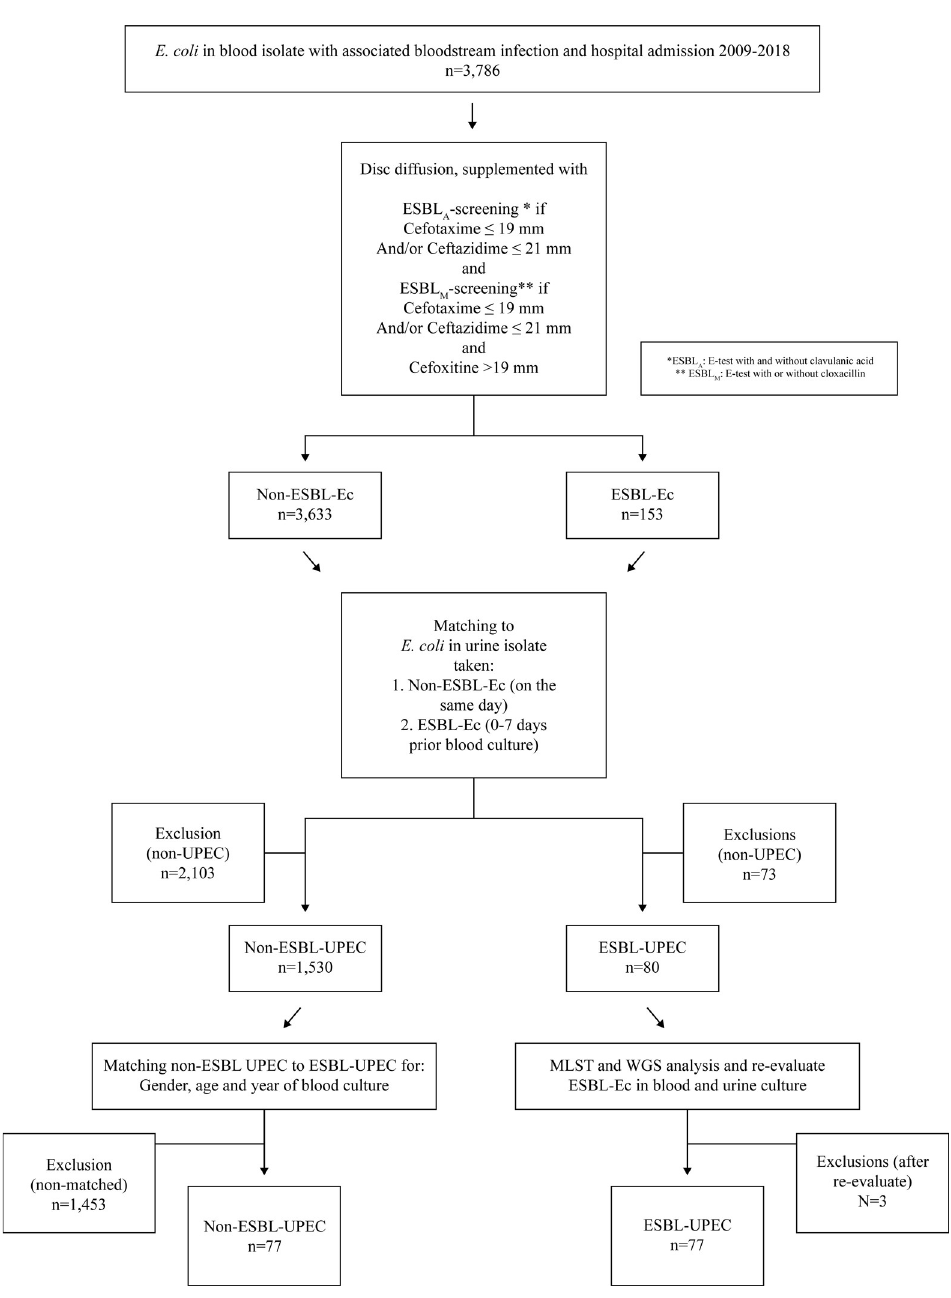
Fig 1. Flow chart of patients with E . coli in blood isolate with associated bloodstream infection, 2009–2018 who were assessed for eligibility (n = 3,786) and further inclusion of ESBL-UPEC (n = 77) and non-ESBL UPEC (n = 77) in the